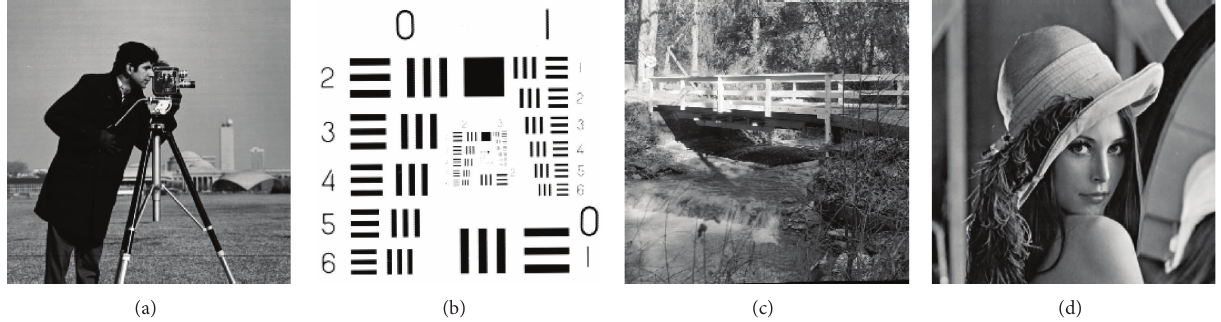
Figure 1: Original images. (a) “Cameraman,” (b) “Resolution Chart,” (c) “Bridge,” (d) “Lena.”